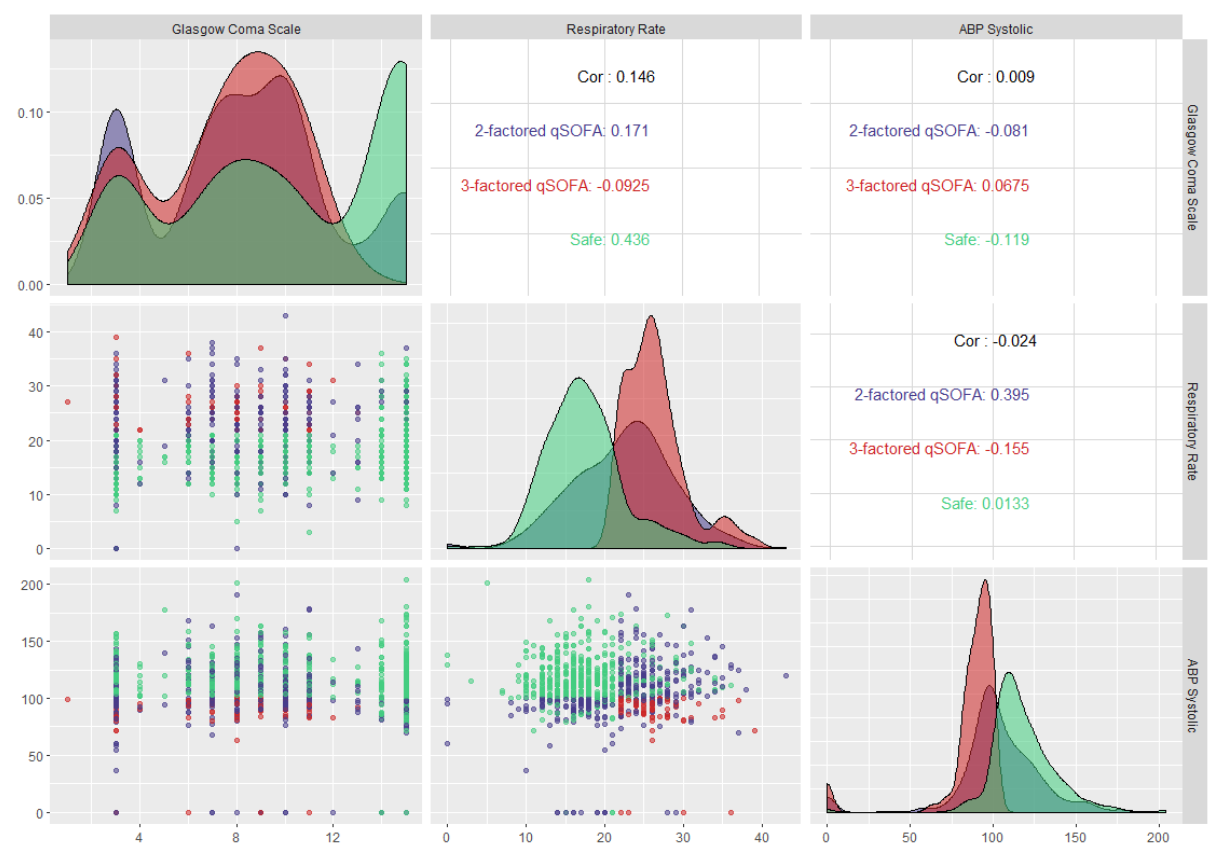
Figure 8. Facet grid illustration of sepsis-3 (qSOFA) parameters to capture the underlying relationship between parameters and the most